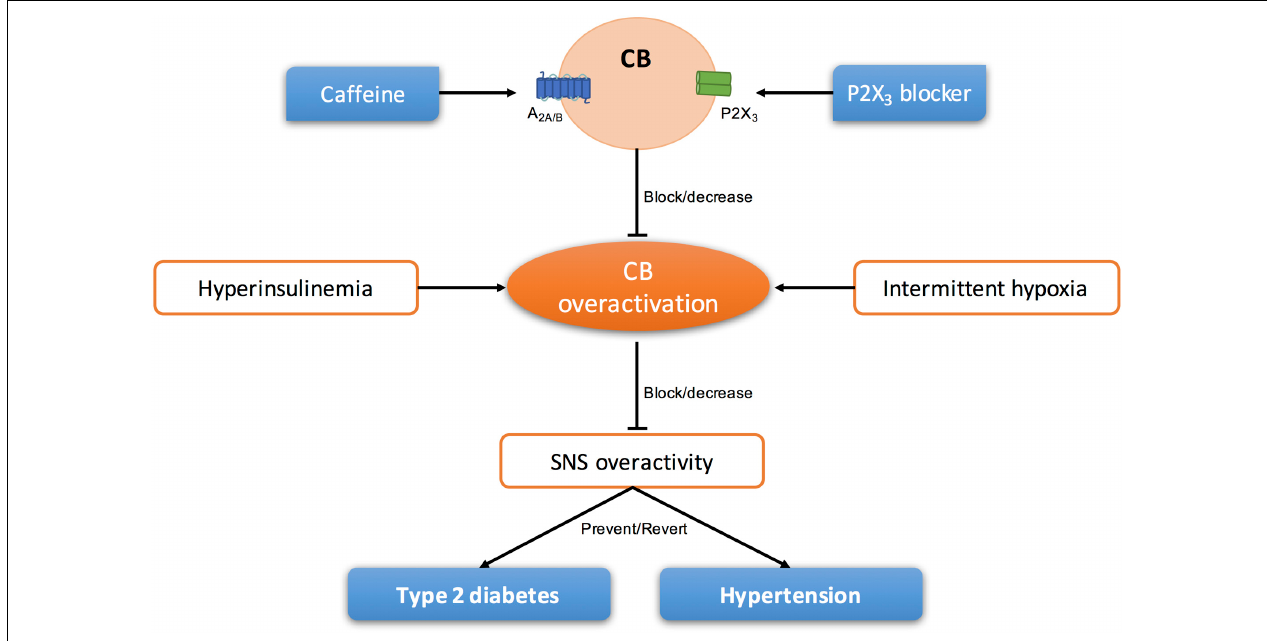
FIGURE 4 | Schematic representation of the modulation of purinergic systems to block/decrease the overactivation of CB present in sympathetic-mediated diseases, as type 2 diabetes and essential